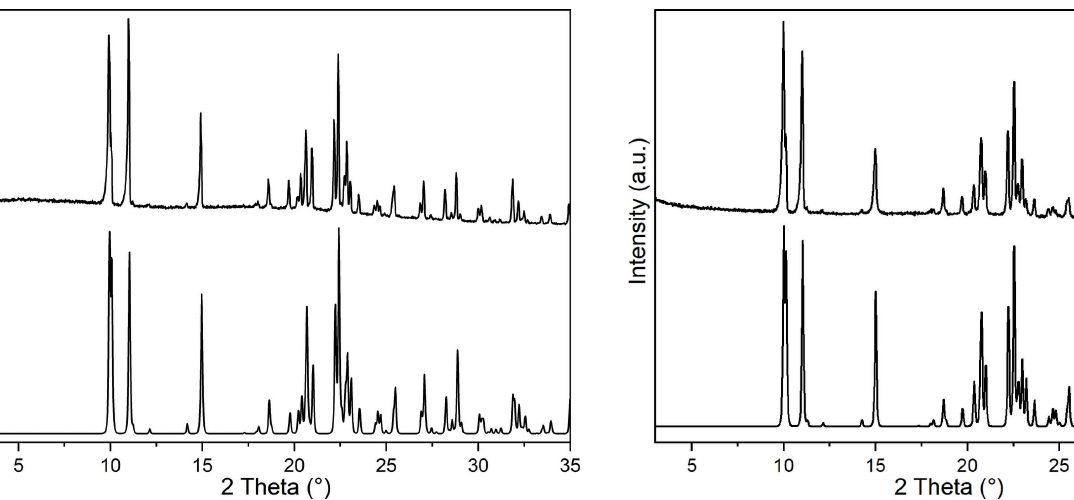
Figure 1 Experimental (top) and calculated (bottom) X-ray powder patterns of compound 1 measured with Cu K (cid:2)